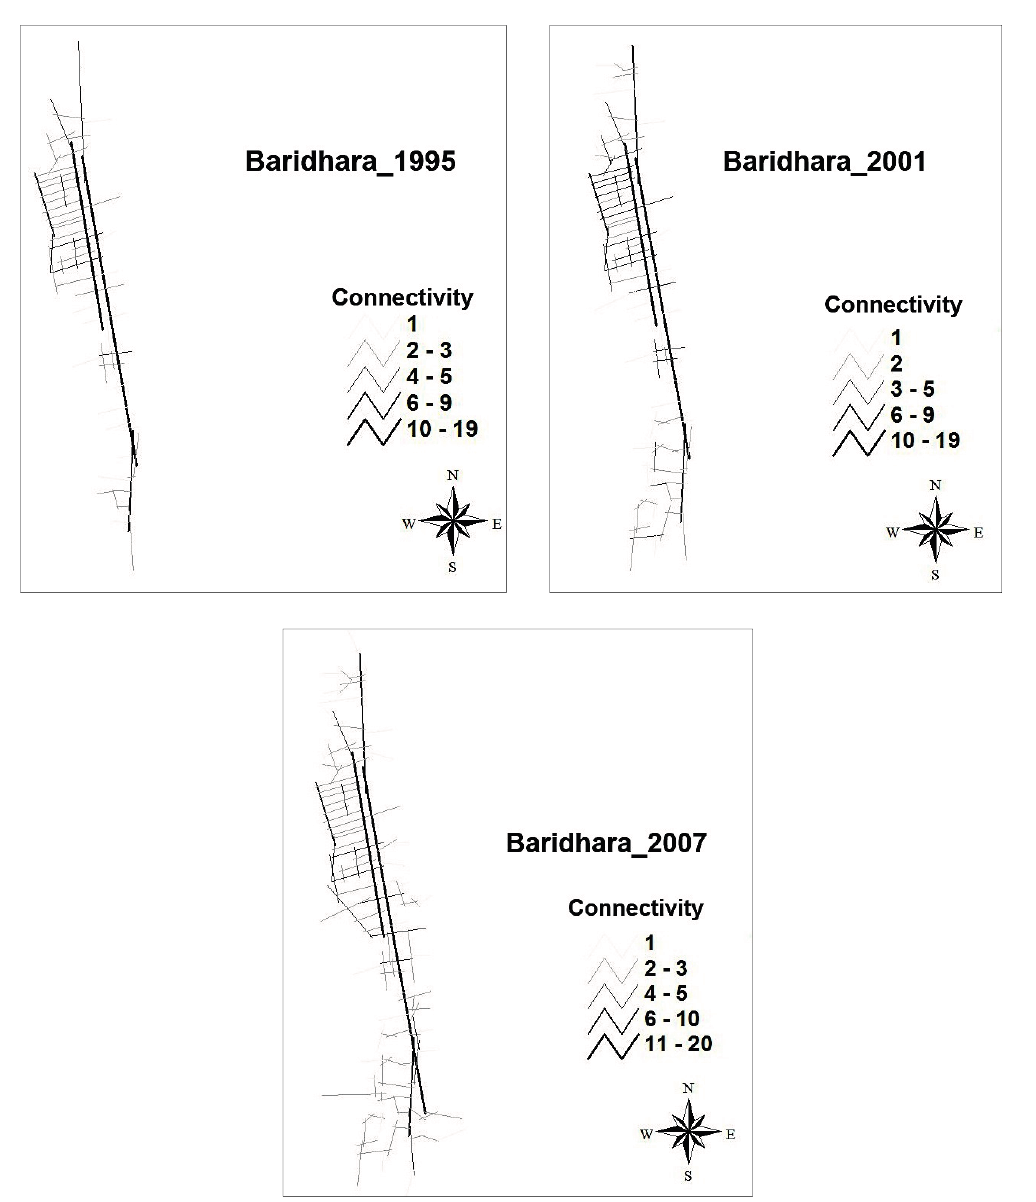
Figure 11. Connectivity maps of ward 18 (Baridhara) in different time periods (not to